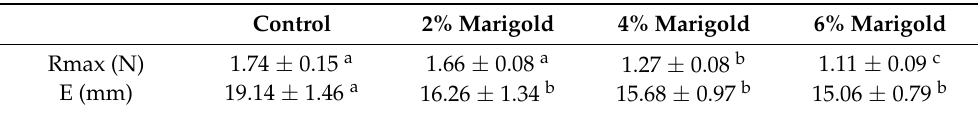
Table 1. Effect of marigold powder on the tensile properties of noodles after cooking (means with different letters in the same row differ significantly at p < 0.05).